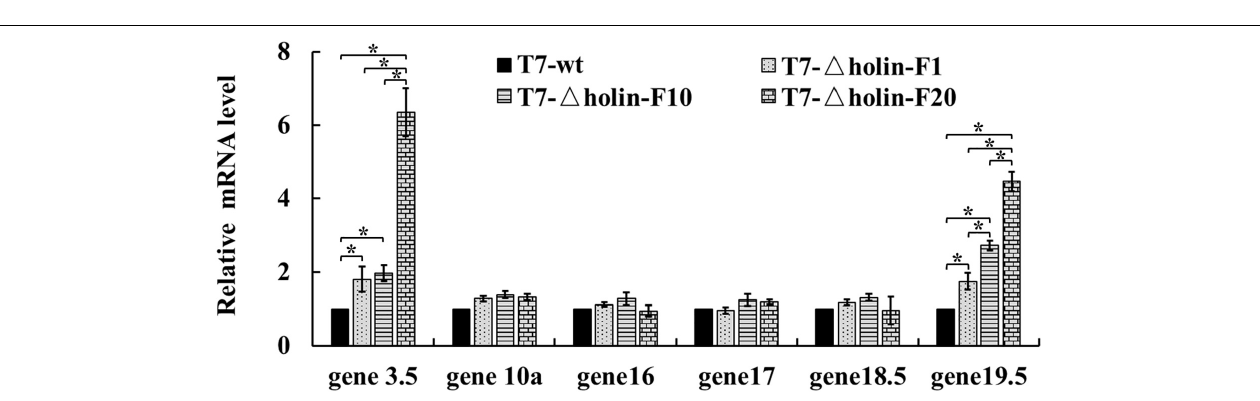
FIGURE 5 | The mRNA levels of T7-wt and T7- (cid:52) holin during infection. The mRNA levels of several T7 genes in the T7-wt and the 1st, 10th, and 20th generations of the T7- (cid:52) holin phage infections measured using quantitative real-time PCR. Escherichia coli BL21 cell 16S rRNA was set as a reference control. All data were statistically analyzed using the two-tailed Student’s t -test. Bars with a * indicate significant difference ( p <